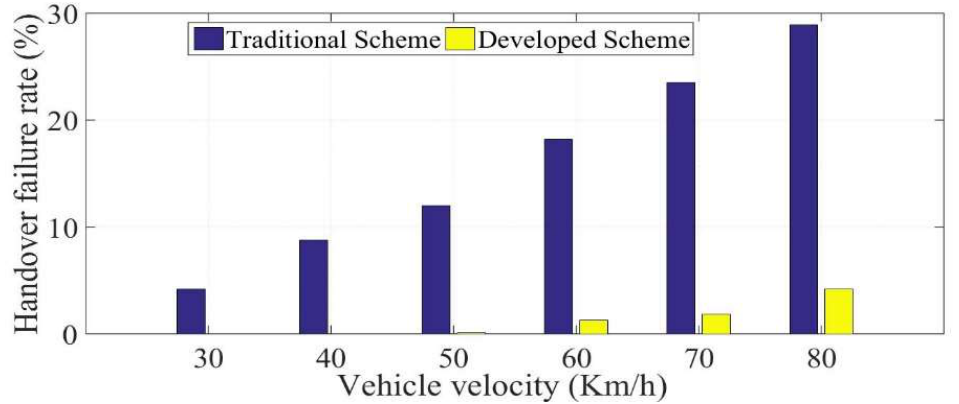
Figure 12. Handover failure rate of traditional handover schemes and the developed scheme at dif- ferent vehicle velocities.